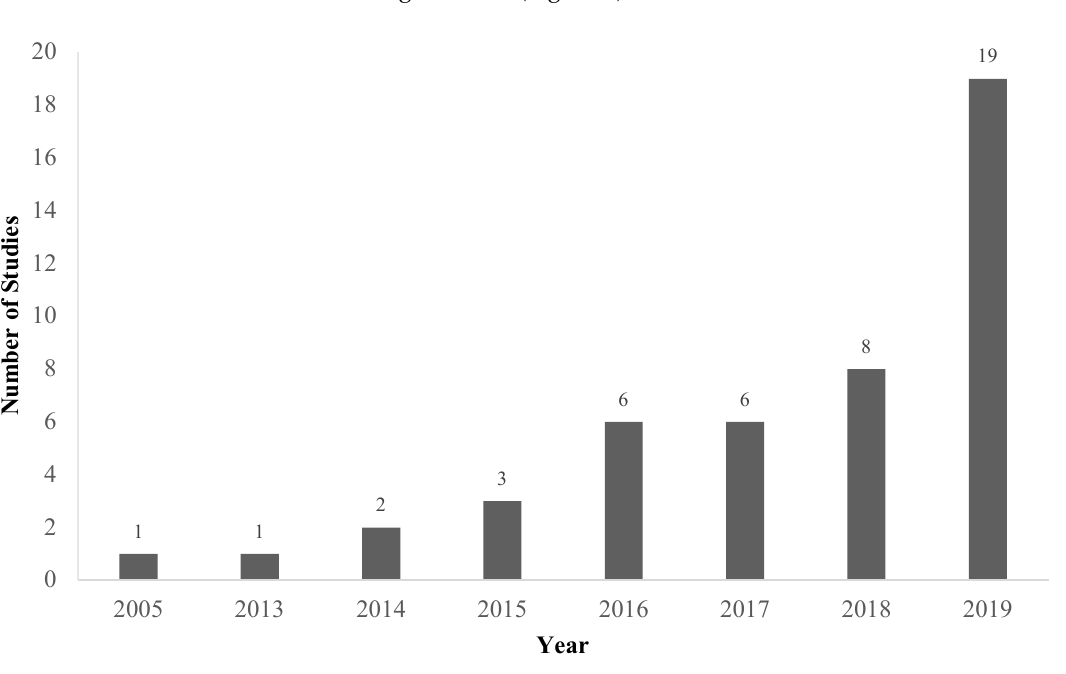
Figure 1. Number of peer-reviewed studies published per year using unmanned aerial system-borne passive sensors to estimate vegetation biomass. Total number (as of 31 August 2019) of papers published on the topic and fitting the requirements of this review =